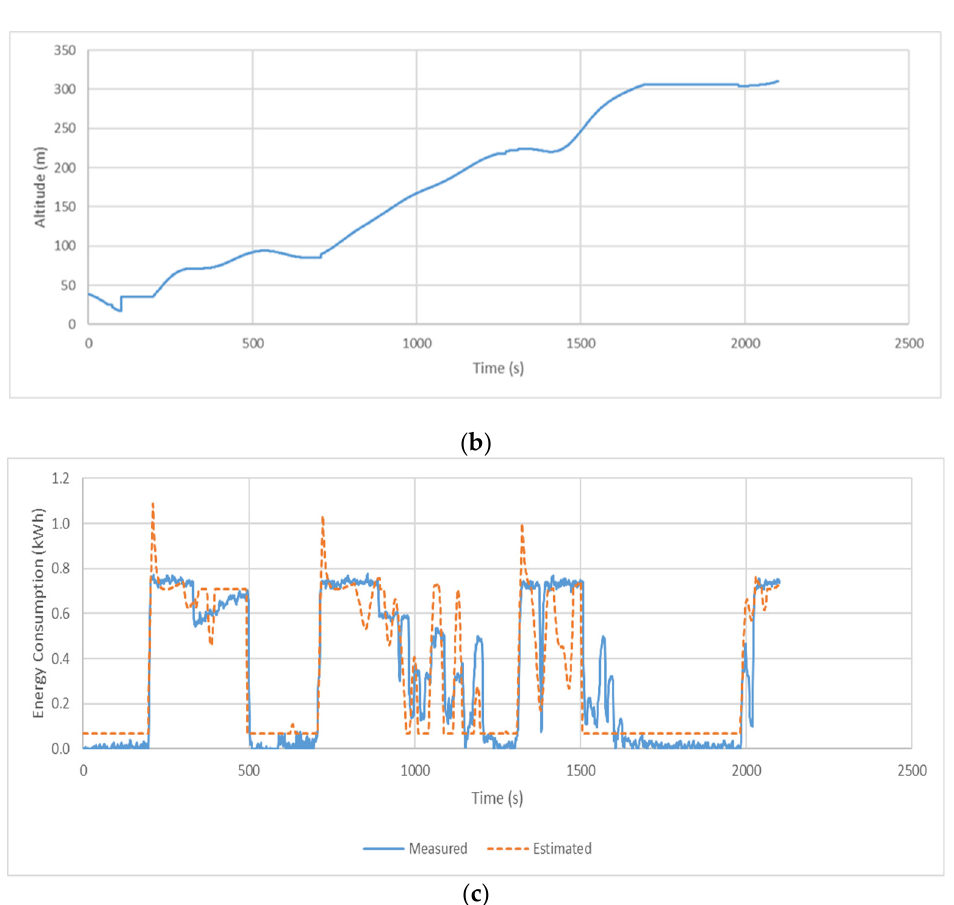
Figure 7. Model validation using Valencia to Cuenca trip data: ( a ) speed profile of a sample section, ( b ) altitude, ( c ) energy consumption.